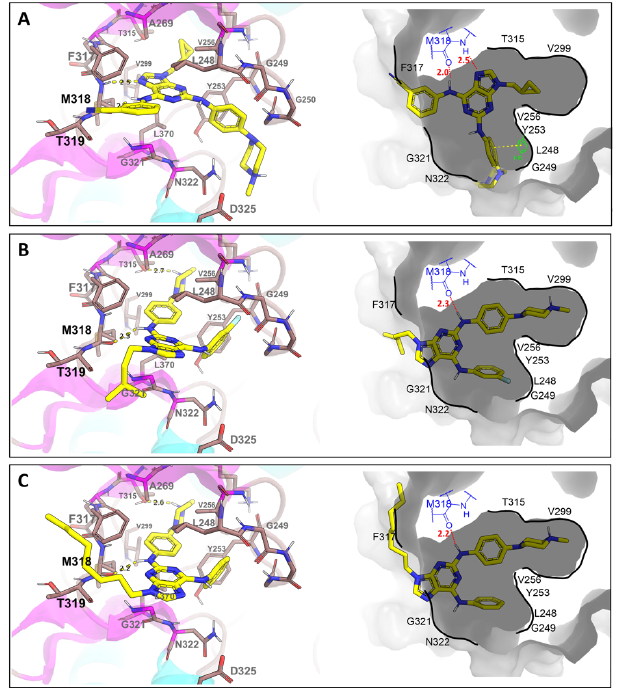
Figure 8. Representations of the binding modes of compounds 4f ( A ), 5b ( B ) and 5j ( C ) at the Bcr-Abl active site. The image on the right is the three-dimensional representation of the best docking result for each compound. The image on the left is a top view of a diagram of ligand interactions with the binding site.